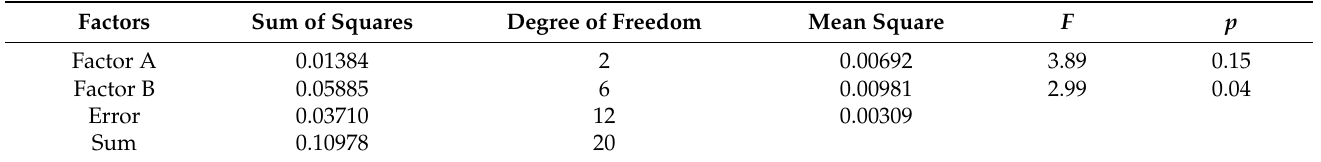
Figure 3. Walnut shell thickness at different measurement points. Table 1. Two-way ANOVA of shell